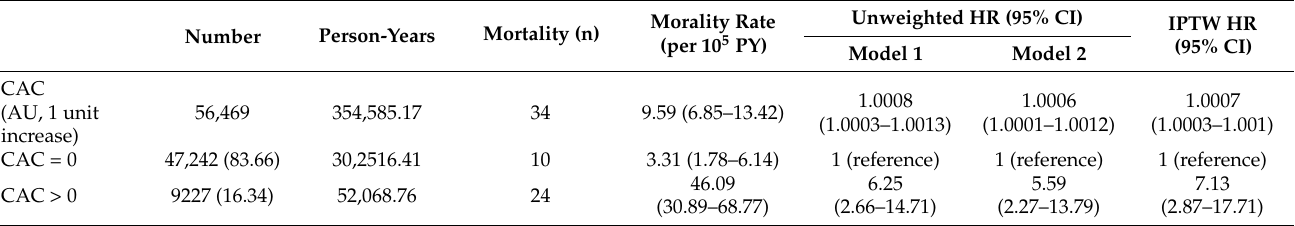
Table 2. Mortality rate based on